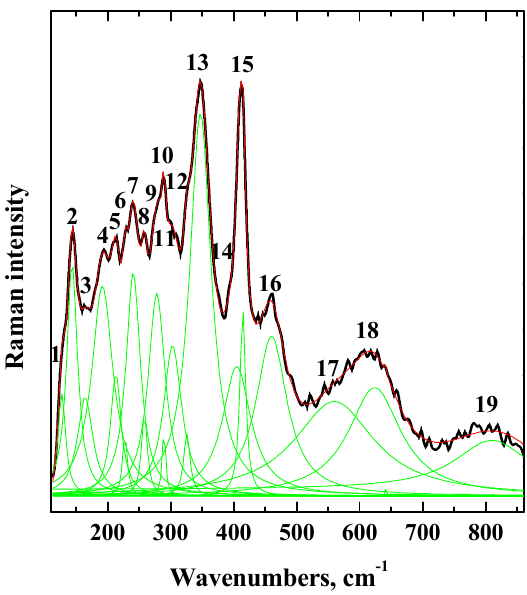
Figure 2. Raman spectrum of SrLa 2 Sc 2 O 7 composition.